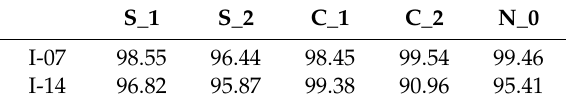
Table 3. Recognition accuracy of fault labels I-07 and I-14 using single attention mechanisms.